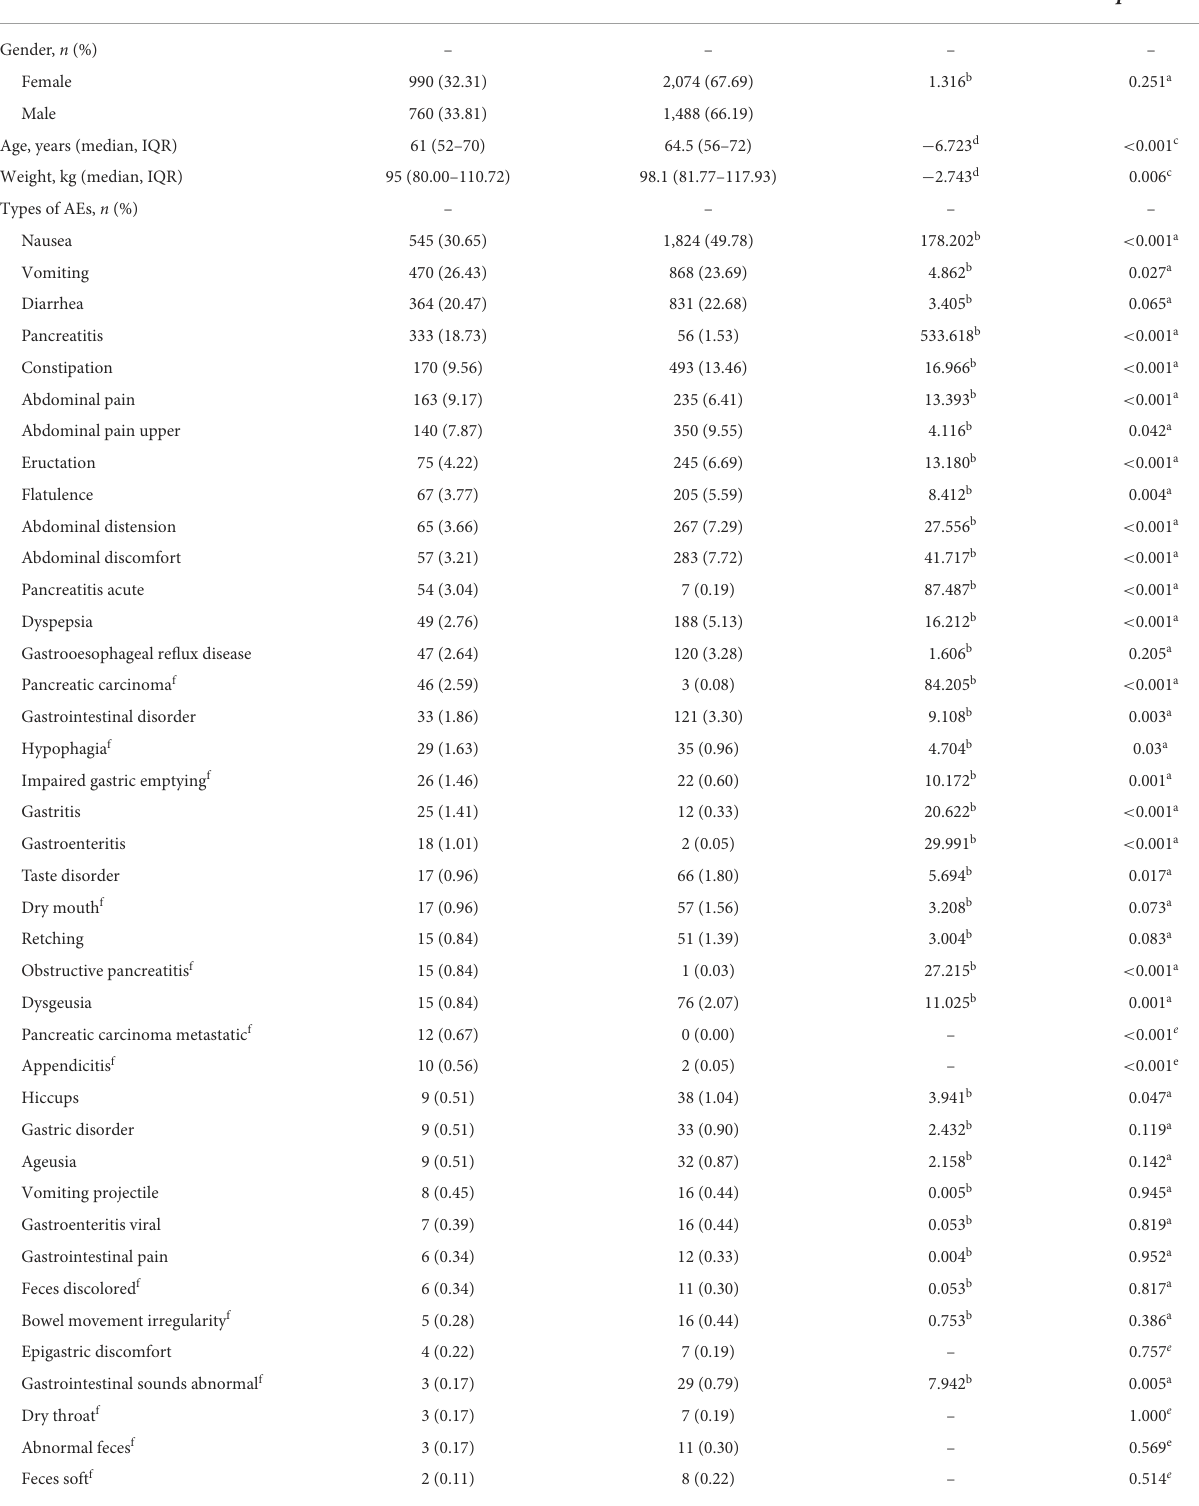
TABLE 2 Differences in clinical characteristics of serious and non-serious